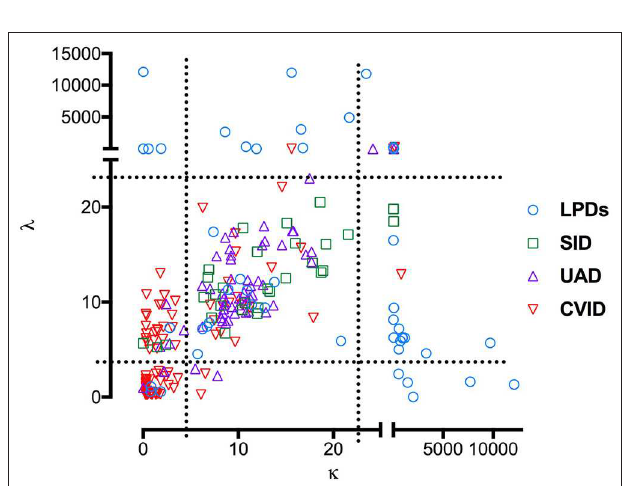
FIGURE 2 | Combined sFLC levels in the differential diagnosis of hypogammaglobulinemia. The scatter plot shows sFLC levels for 345 patients with CVID (red triangles), UAD (purple triangles), LPDs (blue circles) and non-hematological SID (green squares). Dashed lines represent reference for sFLC